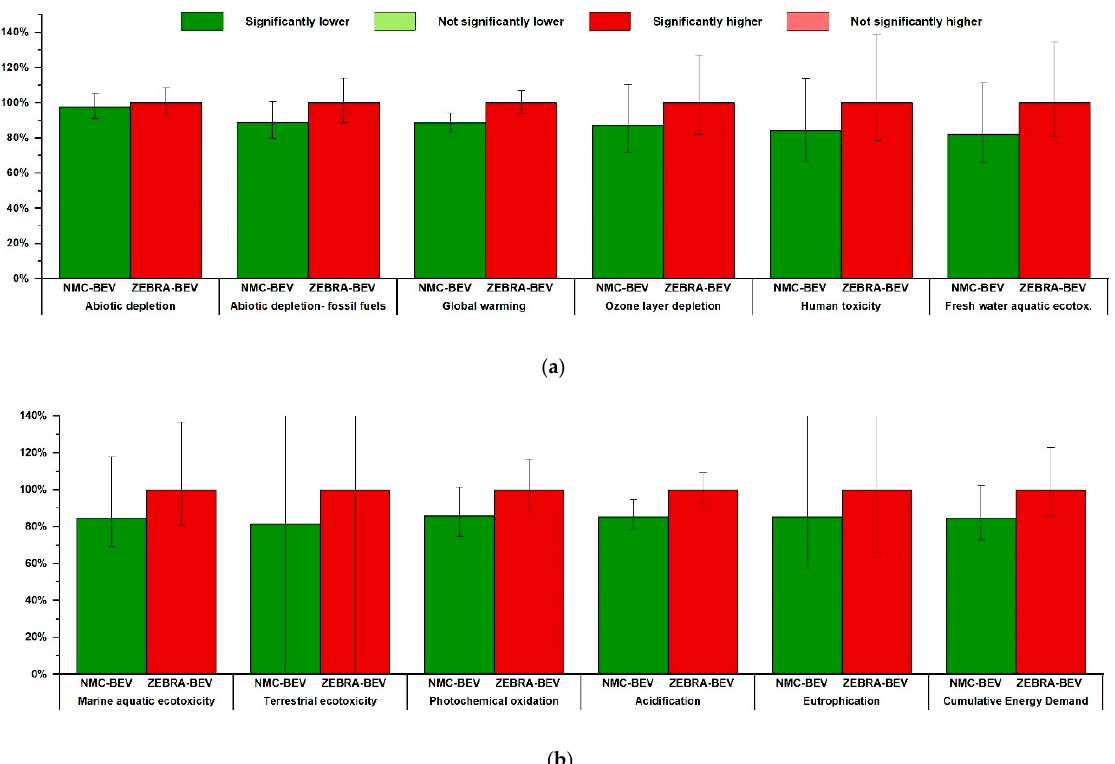
Figure A1. ( a , b ) Graphical representation of the comparison of the uncertainty range of the BEV vehicles. In this Monte Carlo analysis, the NMC111-BEV is powered by 2 battery packs. Some impact categories present higher values than 140% and lower ones than 0%.